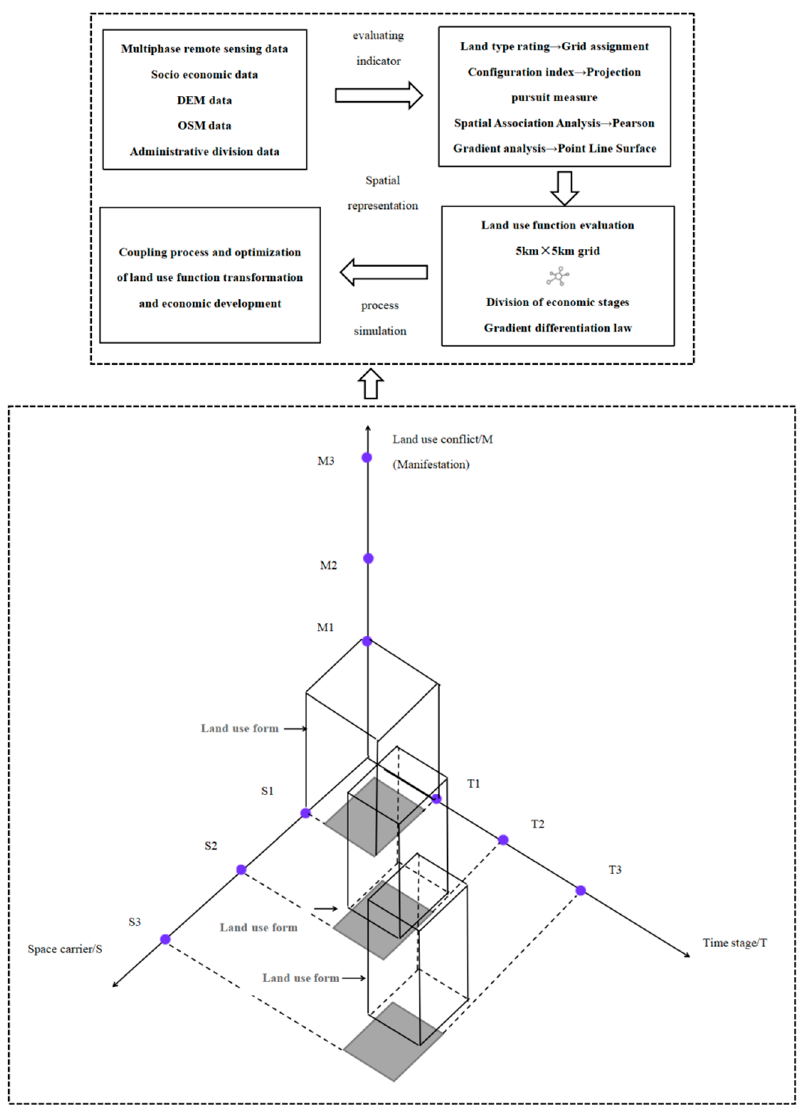
Figure 2. workflow